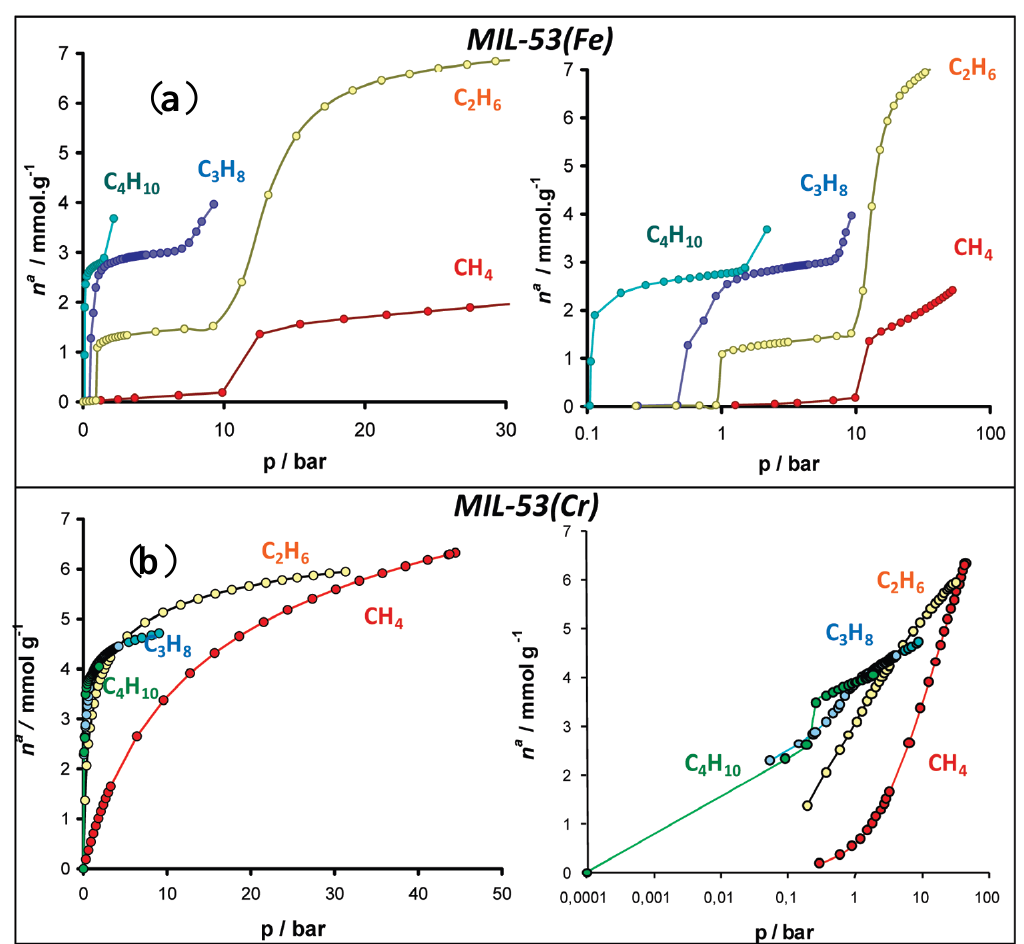
Figure 15. Adsorption isotherms of C1-C4 alkanes at 303 K. ( a ) MIL-53(Fe); ( b ) MIL-53(Cr). Reprinted with permission from [106]. Copyright 2009 American Chemical Society.